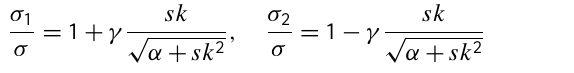
Fig. 3. LES data of ARM, ASTEX, RICO and DYCOMS and observational data from the RICO campaign along with the closure equations from Larson et al. (2001a) (dashed line) and the new closure equations (solid line). Note that the new closure equations are fitted to the LES data of RICO and DYCOMS rather than to all available case studies. The grey shading in (c) corresponds to two times the standard deviation from the four LES cases in (a). The legend in (a) also applies to (b).